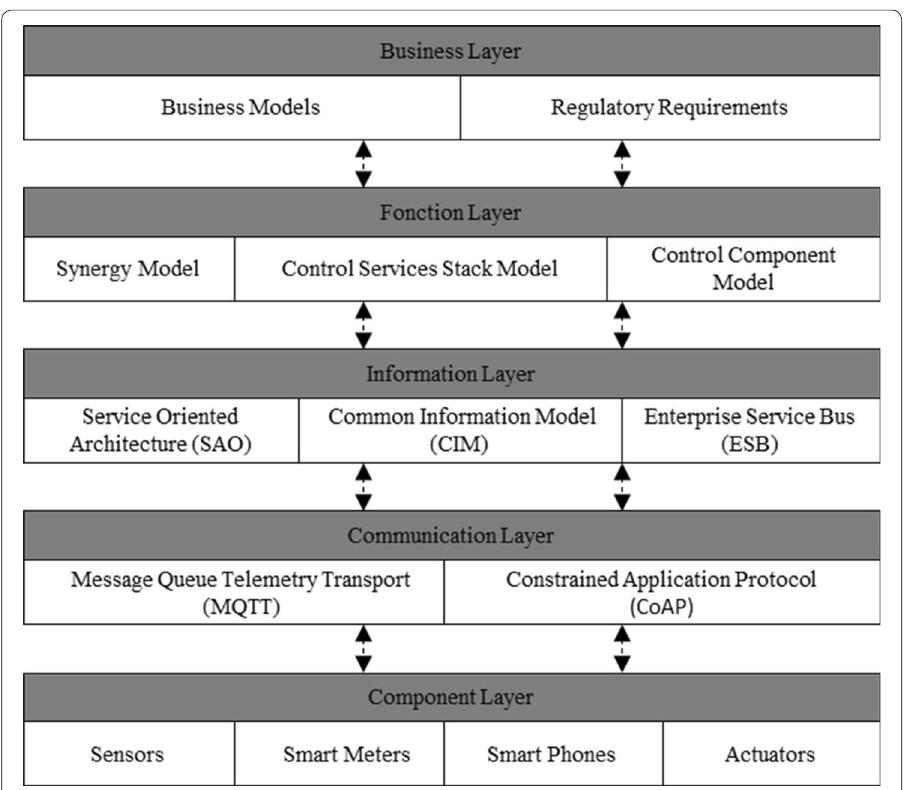
Fig. 2 Smart grid infrastructures layers. Smart grid layers interact together to ensure energy